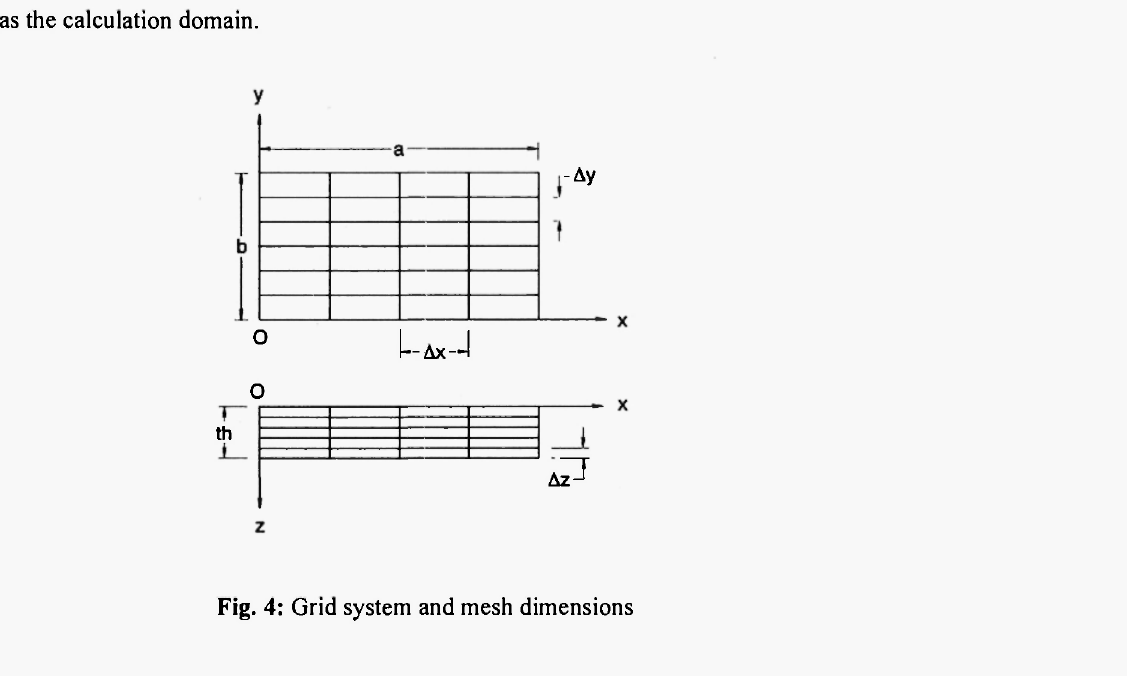
Fig. 4: Grid system and mesh